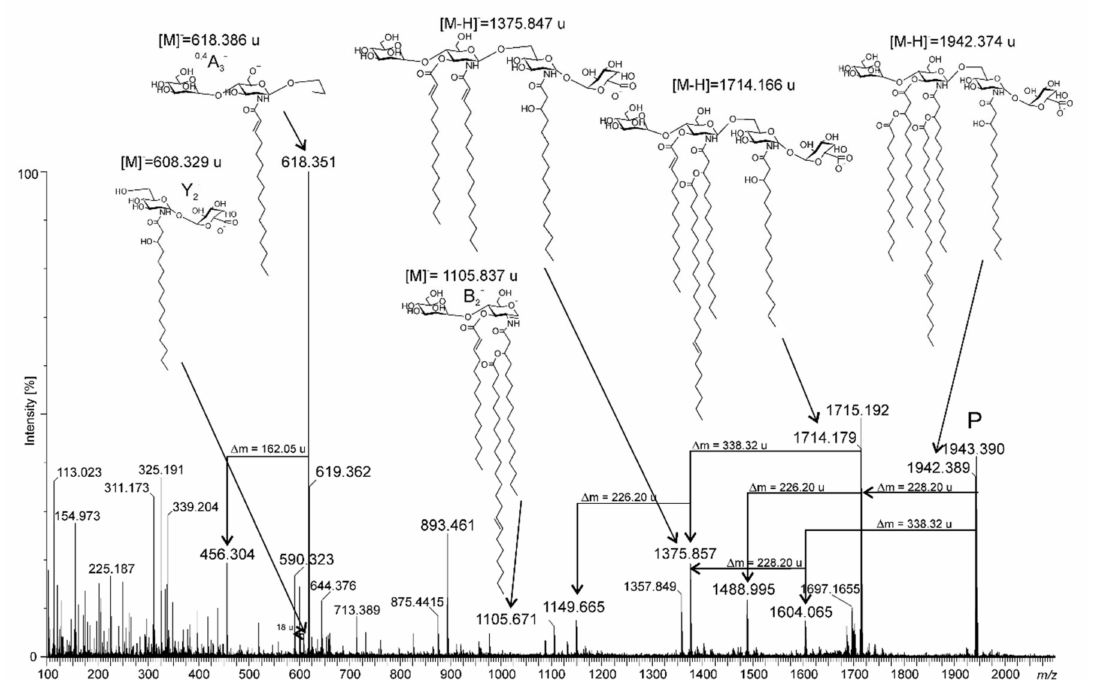
Figure 5. Negative ion ESI-MS-MS spectrum of the signal at m / z